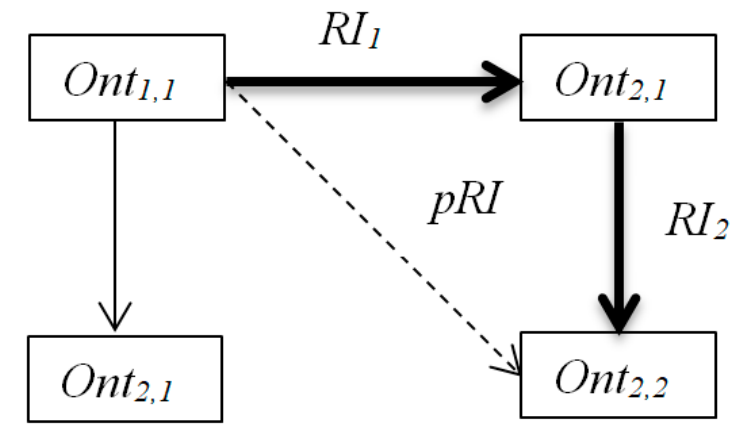
Figure 2. Fragment of the transitive integrity of the structure.